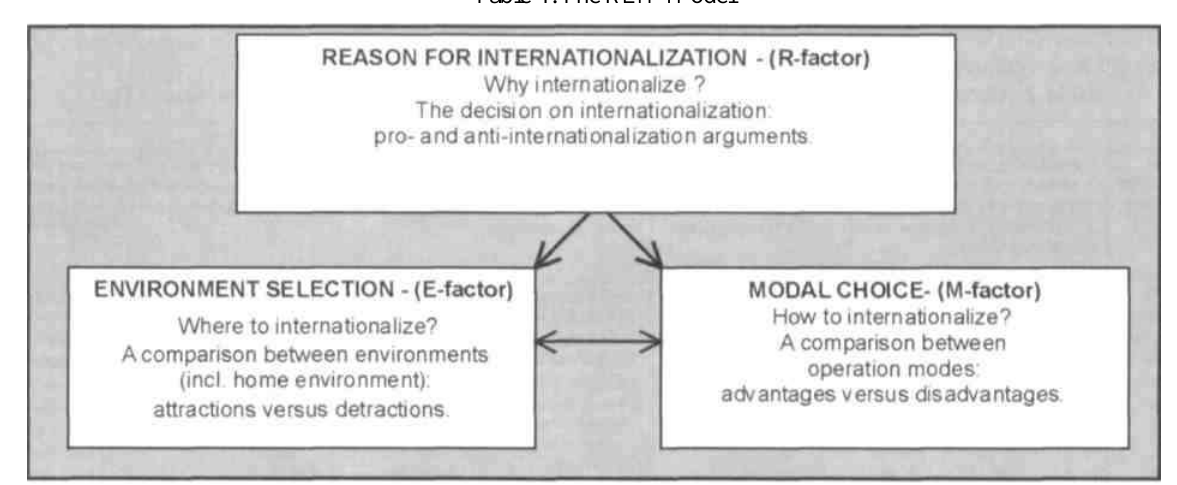
Table 4. The REM